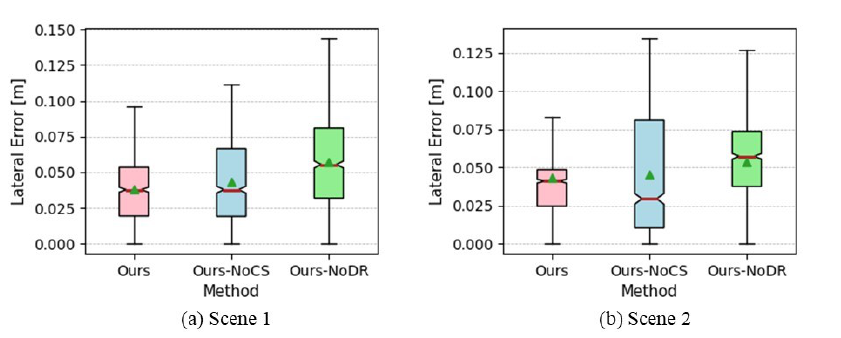
Figure 14. Lateral